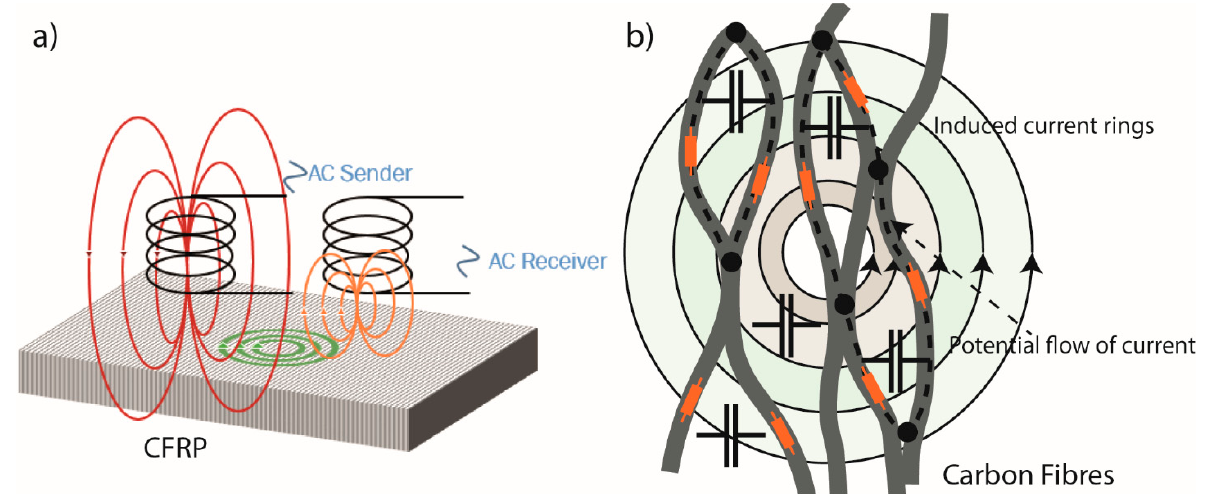
Figure 1. ( a ) Schematic of probe configuration for EC testing; ( b ) electric and dielectric behaviour of CFRP. Carbon fibre materials can be simplified as a network of resistors and capacitors, adapted from